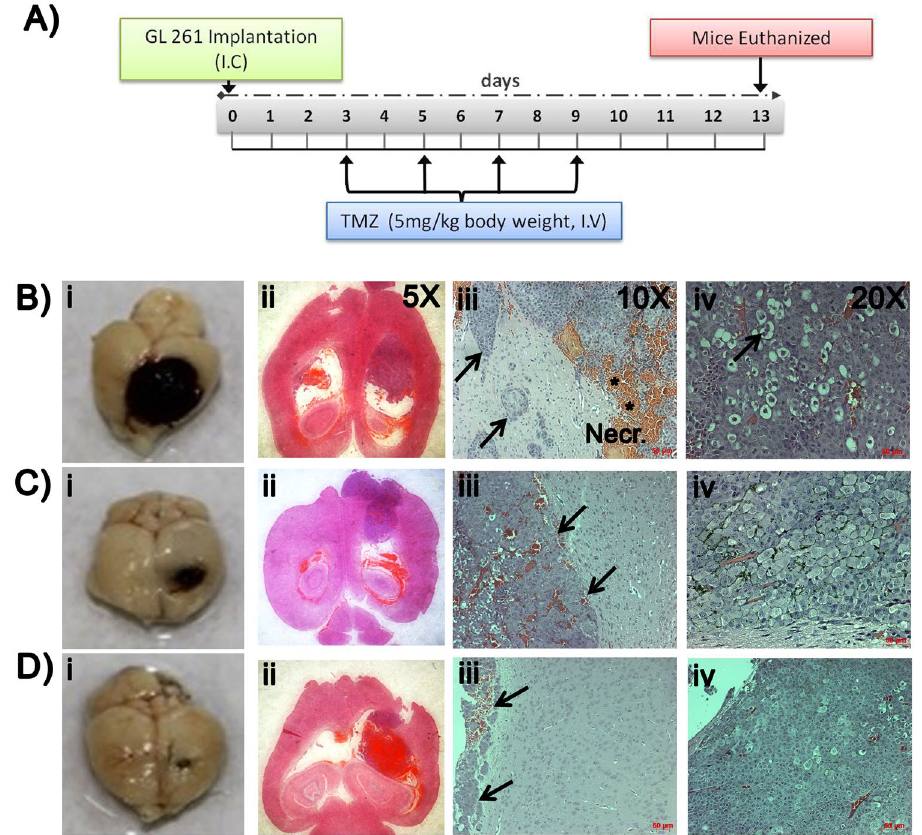
Figure 6. ( A ) Treatment schedule. Photomicrographs of brain (i) and histological brain sections at 5X (ii), 10X (iii) and 20X (iv) magnification obtained from brain dissected from glioma bearing mice treated with PBS (B) , TMZ (C) , and TMZ-LfNPs (D) . (Necr. represents necrotic area with numerous penetrating tumor cells and blood vessels in the periphery of the tumor cell islets (arrows) as well as areas of haemorrhage